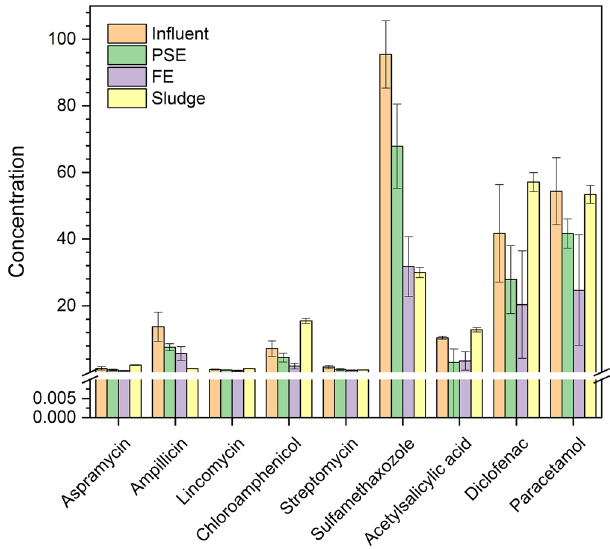
Figure 2. Existence of the different PhACs in the wastewater samples during the different stages of Zenin STP and the distribution of PhACs in the sludge (i.e. concentration unit for the liquid phase is µg L −1 and concentration unit for the sludge is mg kg −1